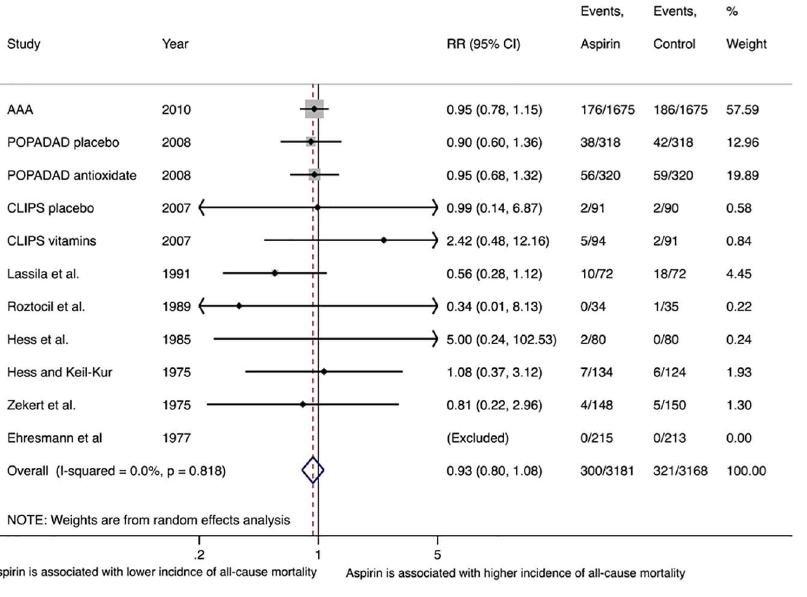
Fig 2. Random-effects summaryplot for the primary efficacyoutcome of all-cause mortality. The relativesize of the data markers indicatesthe weight of the sample size from each study. CI = confidence interval, RR = risk ratio. P-value representsChi-square test of